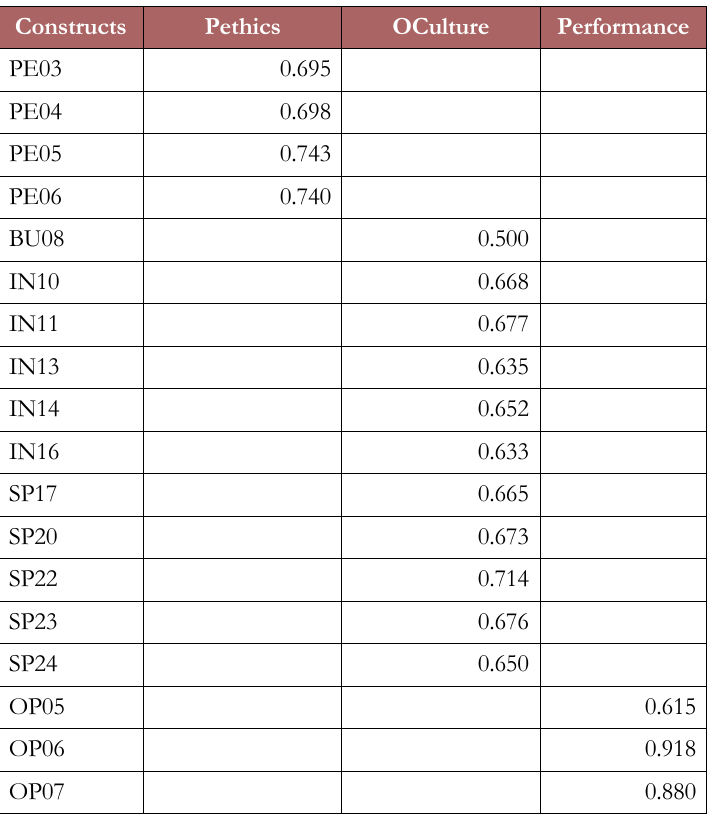
Table 3. Construct